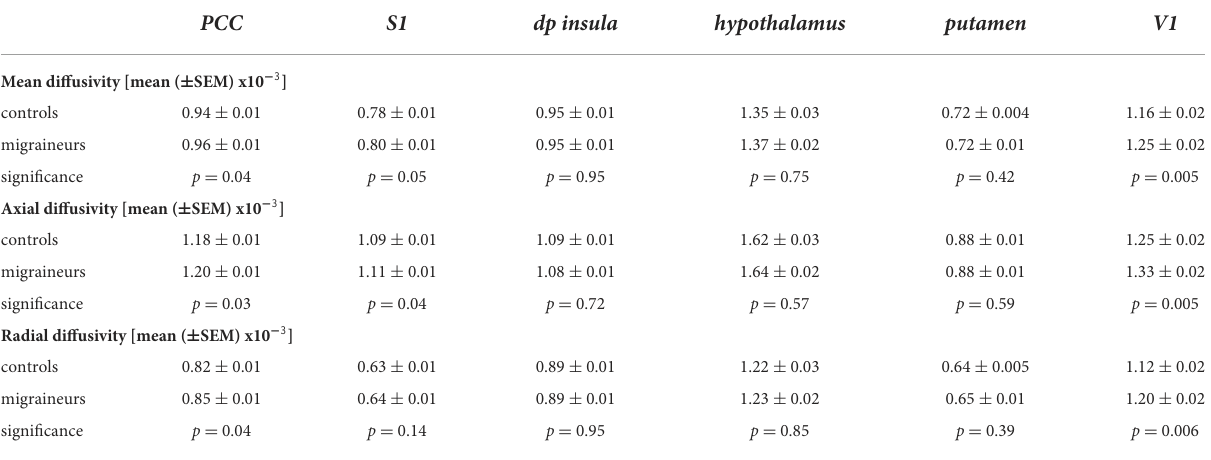
TABLE 3 Diffusion and p- values for significant wholebrain clusters in migraineurs and controls. PCC S1 dp insula